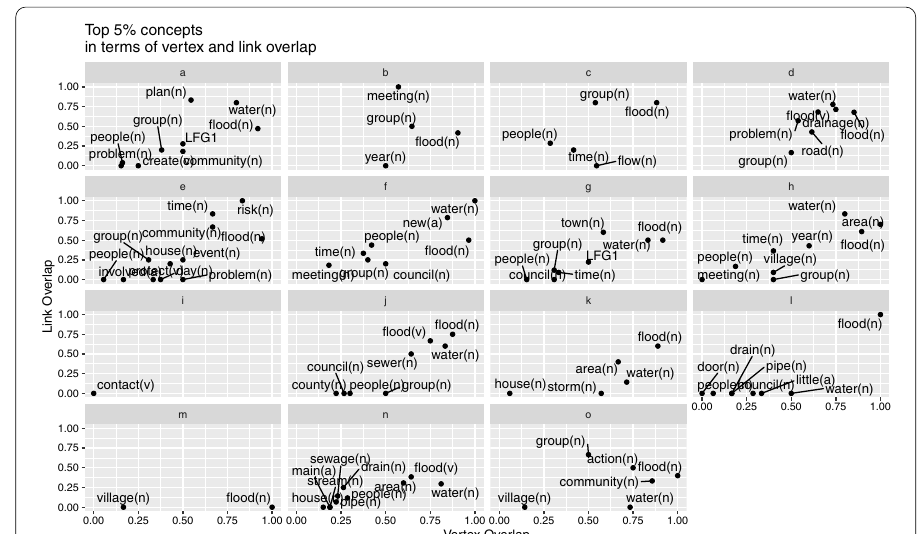
Fig. 10 Professional network with threshold of 2 compared with local networks